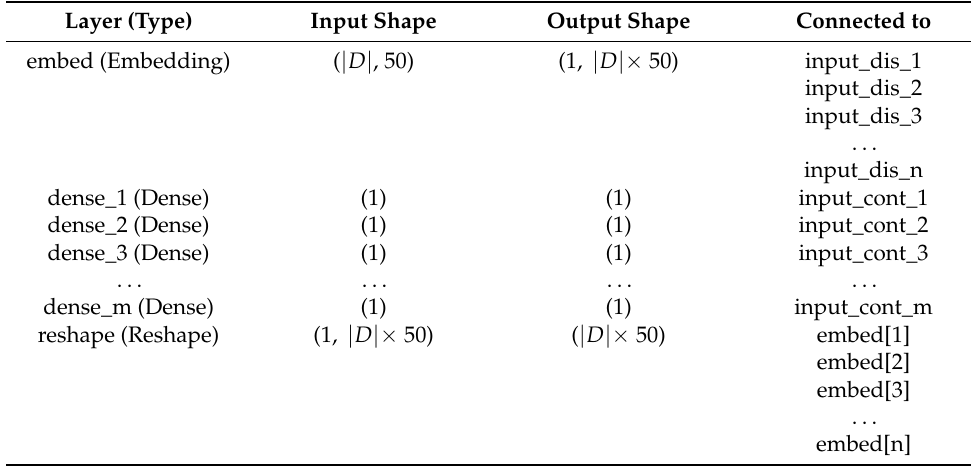
Table 2. Input layer for SOP and connectivity of embedding component.